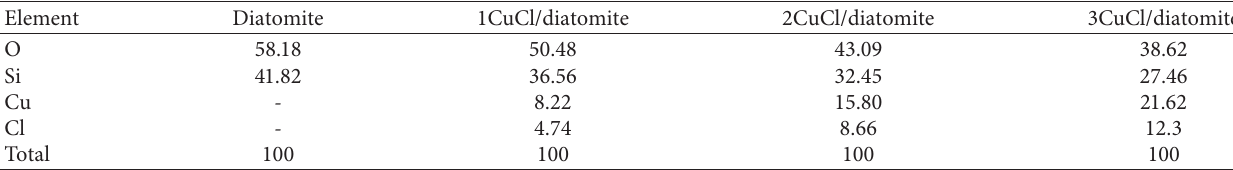
Figure 2: FTIR spectra of diatomite and CuCl/diatomite samples. Table 1: Element composition (wt%) of diatomite and CuCl-modified diatomite determined by